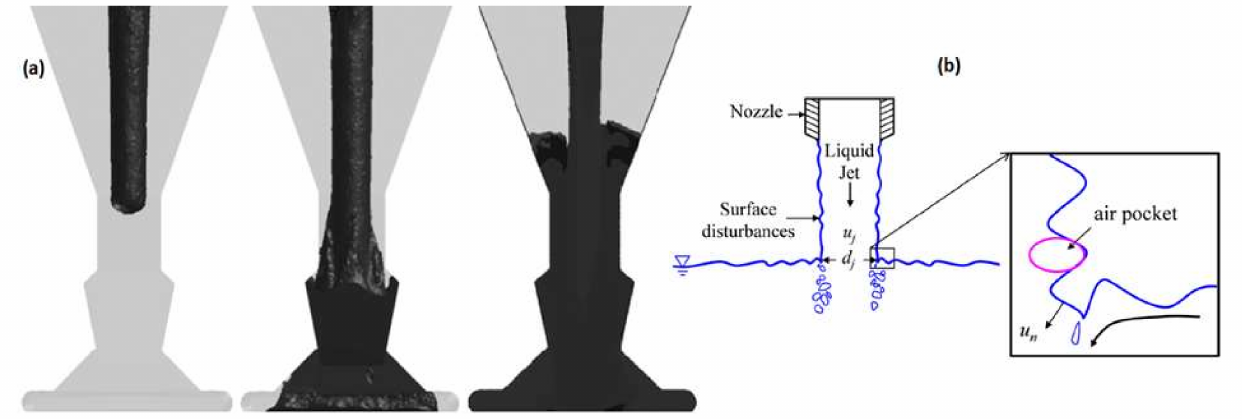
Figure 1. Rising metal level in improperly tapered sprue ( a ) [16]; air entrainment mechanism ( b ) [13].